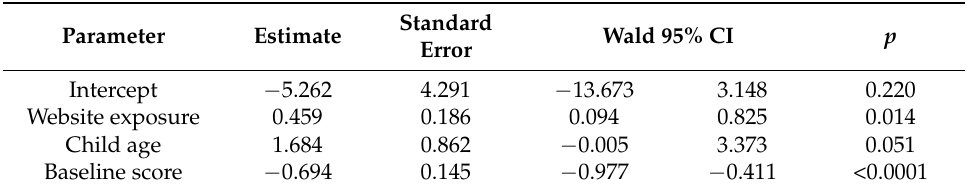
Table 5. Regression Model showing dose response of count of times parent and child used website together on children’s simulated behavior (n =